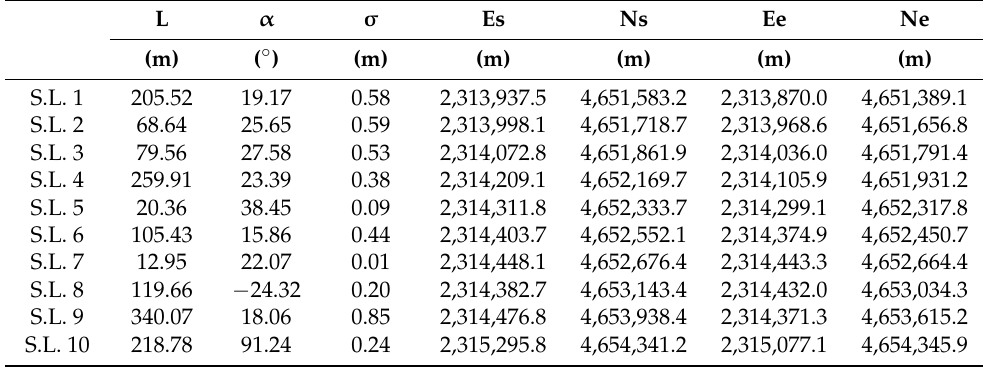
Table 2. Information related to straight lines.